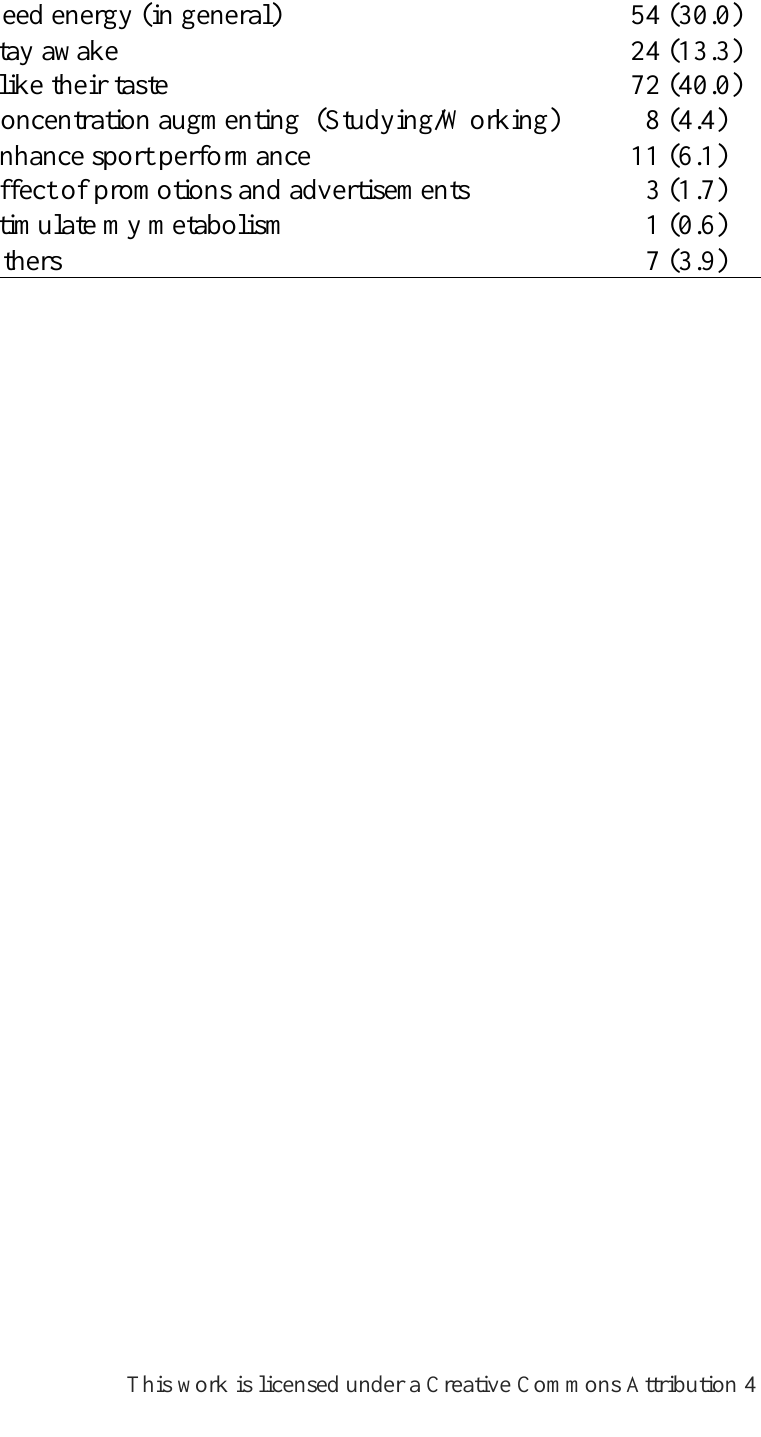
Table 3: Reasons for energy drink consumption Need energy (in